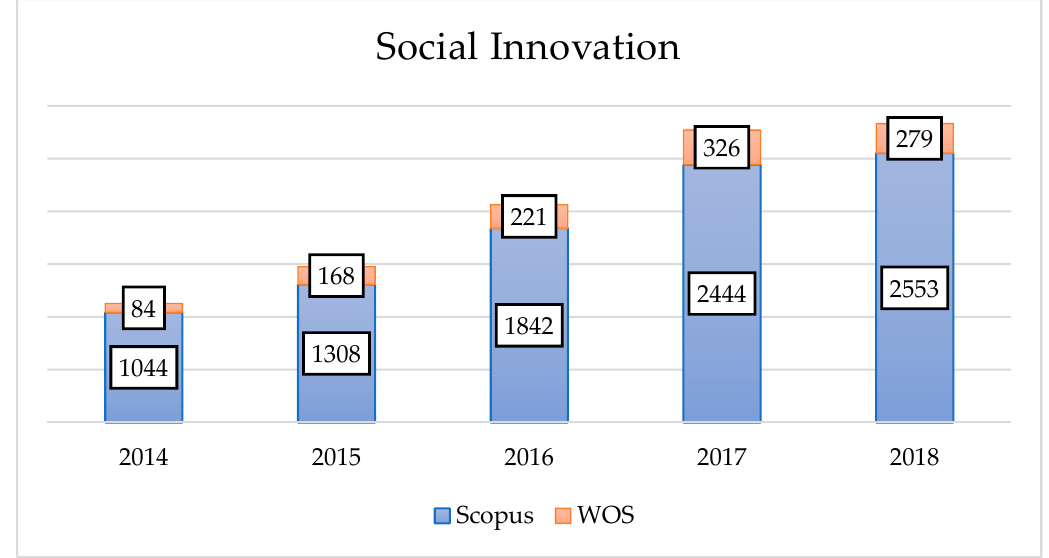
Figure 2. Documents related to social innovation (2014–2018). Source: Query on Scopus and Web of Science (WOS) (2019).